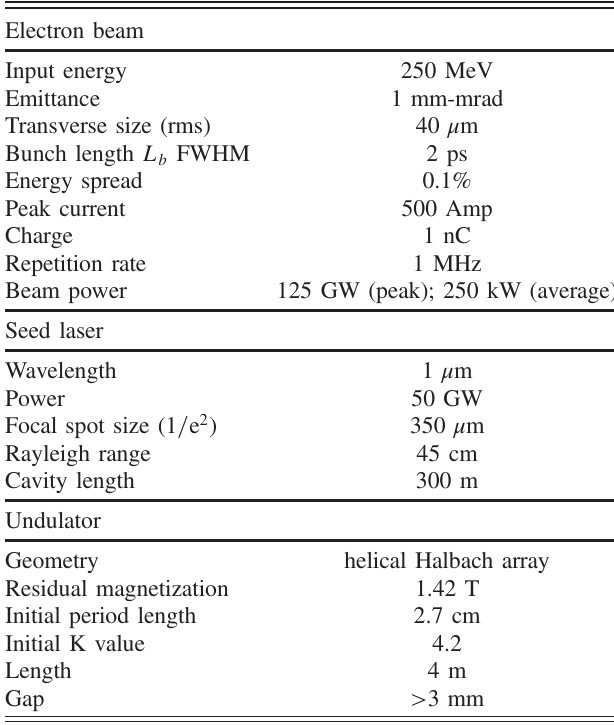
TABLE I. Decelerator parameters.